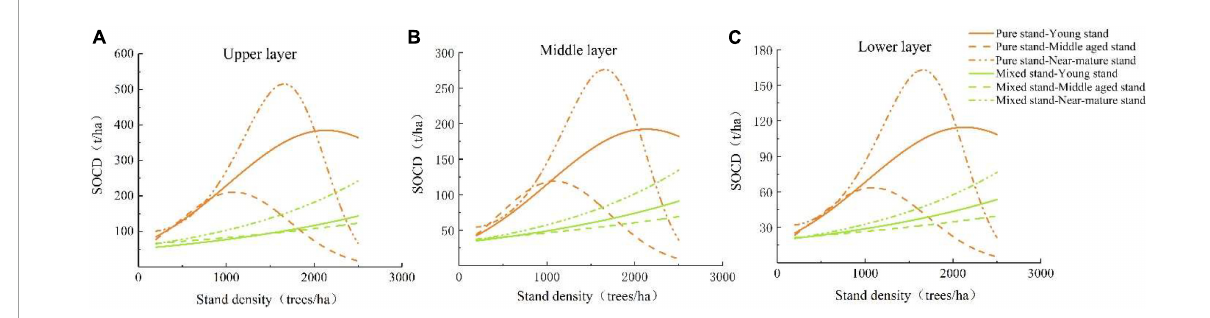
FIGURE4 Soil carbon (SOCD) with different stand densities and different age groups at different depths in pure and mixed P. massoniana stands. (A) SOCD in the upper soil layer with different stand densities and different age groups in mixed and pure P. massoniana stands; (B) SOCD in the middle soil layer with different stand densities and different age groups in mixed and pure P. massoniana stands; (C) SOCD in the lower soil layer with different stand densities and different age groups in mixed and pure P. massoniana stands.